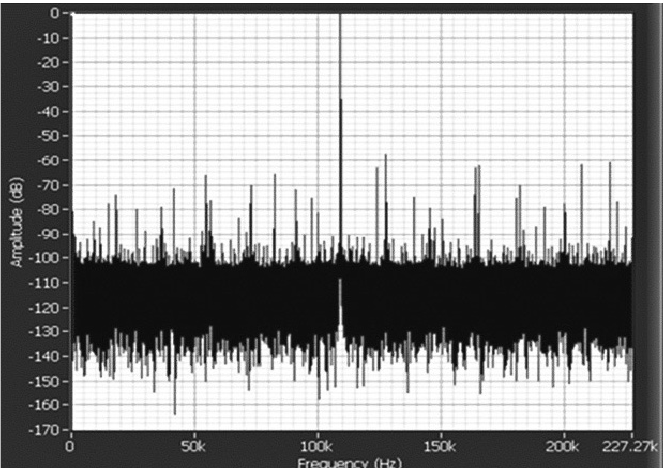
Figure 16. Measured 32768-point PSD of the proposed SAR ADC at an input frequency of 110 kHz.